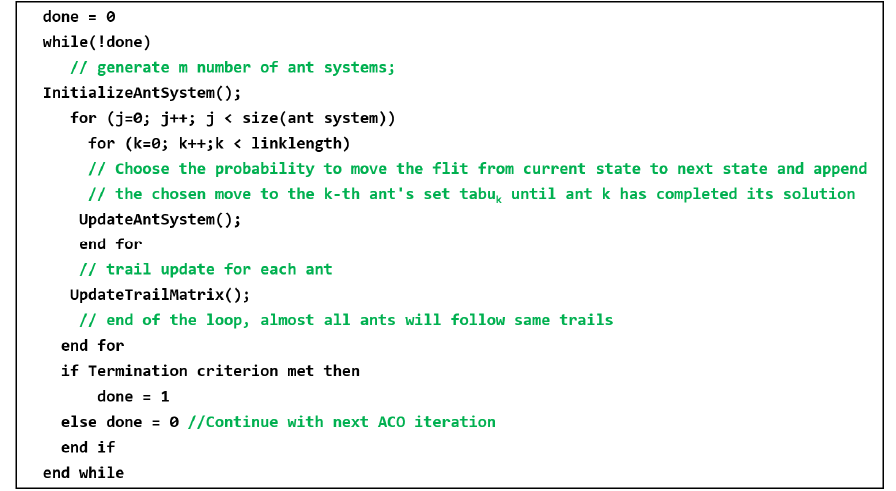
Figure 4. Ant Colony Optimization (ACO) formulation for hybrid photonic NoC synthesis.